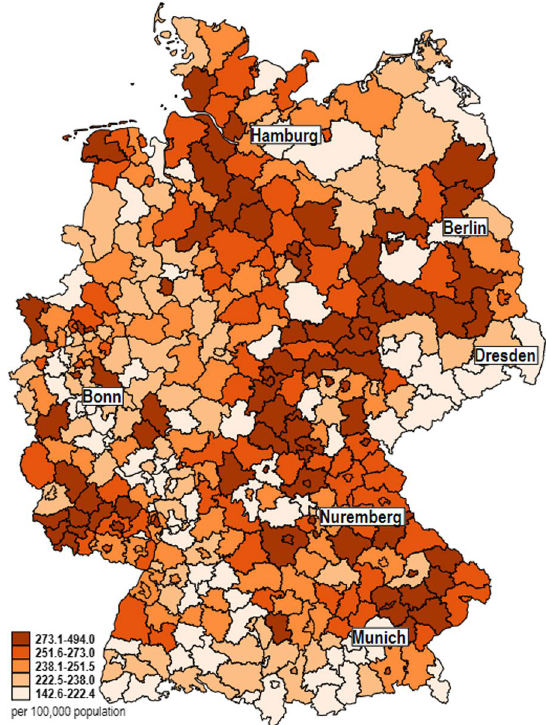
Fig. 2 Distribution of the ischemic stroke rate of districts and